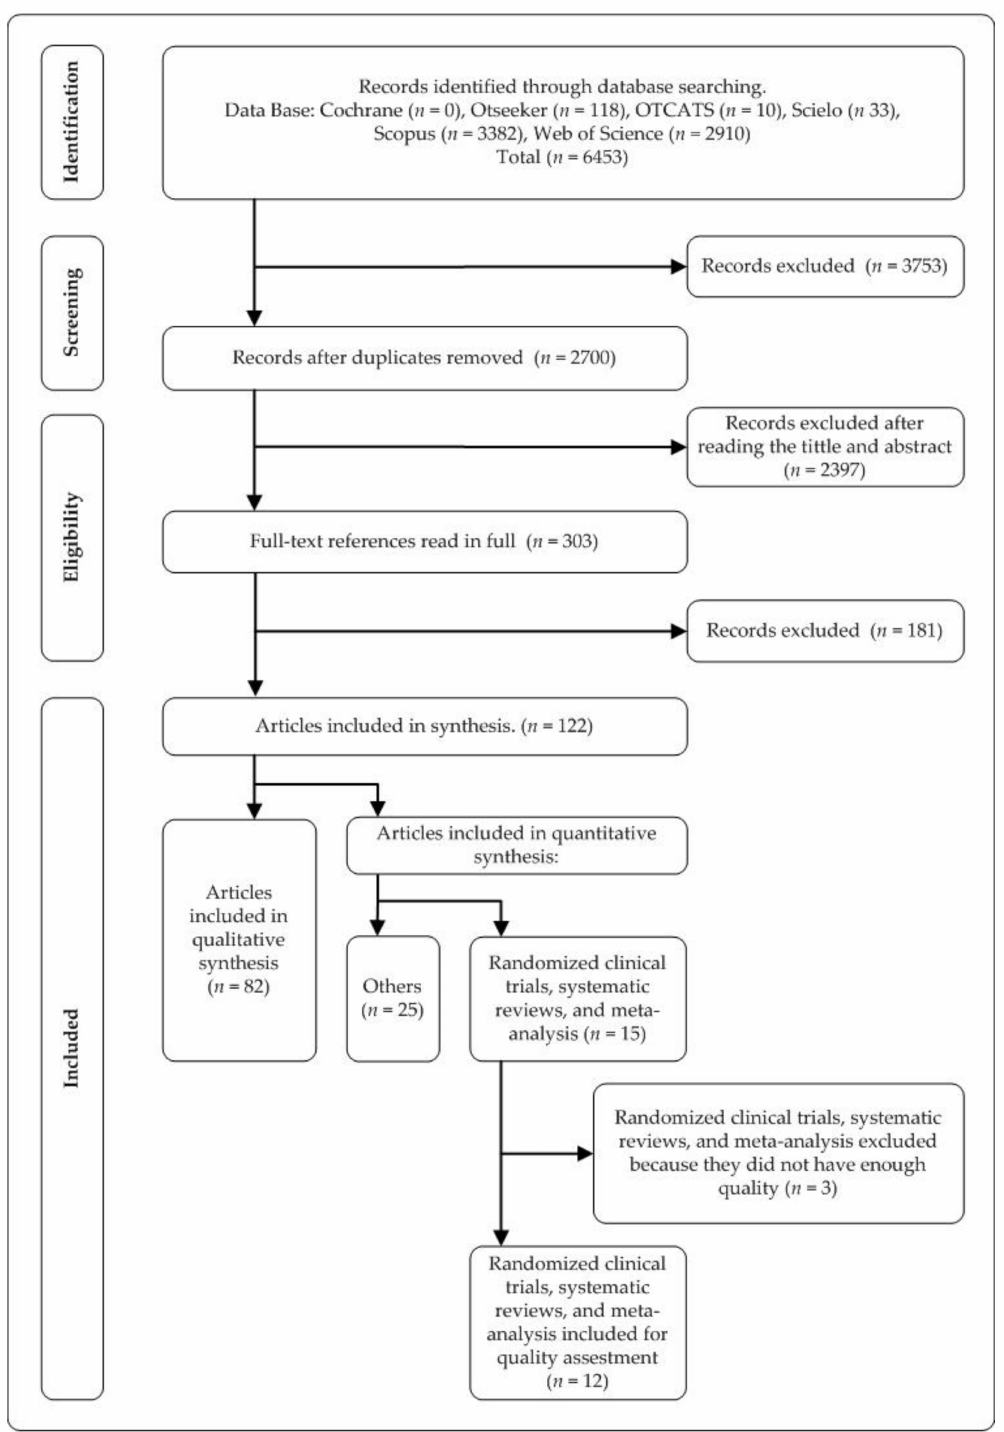
Figure 1. Flow chart